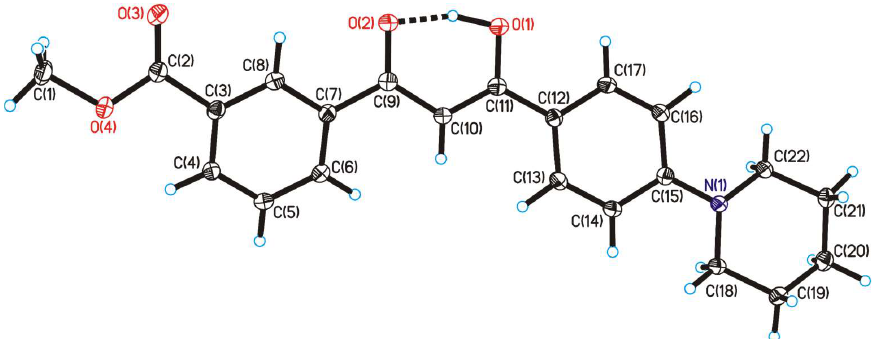
Figure 2. Molecular structure of the title enol. Displacement ellipsoids are shown at 50% probability level.